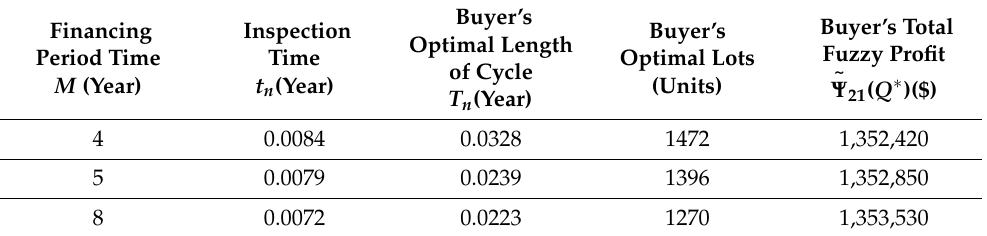
Table 3. Effect of financing period of time on lots, inspection time and buyer’s profit under learn- ing effect.